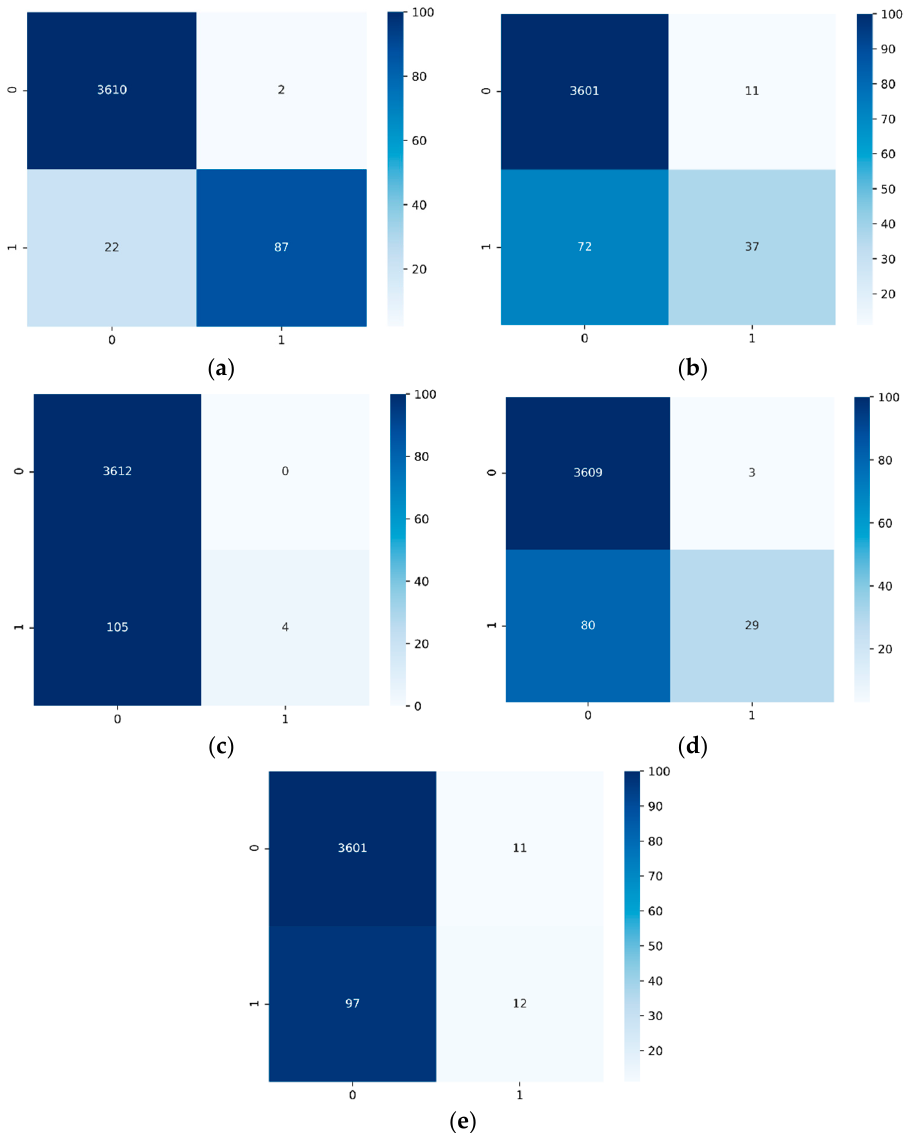
Figure 7. The confusion matrix of binary classification. ( a ) SMO-XGB-SD; ( b ) XGBoost; ( c ) RF; ( d ) SVM; ( e ) LR.